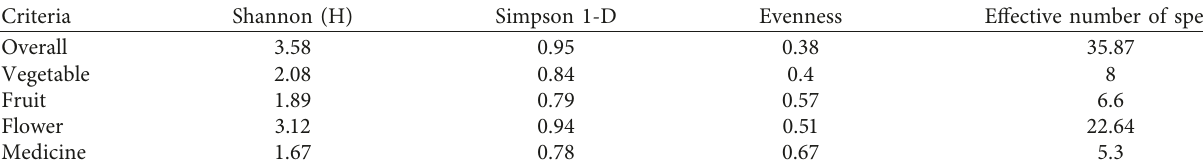
Table 8: Diversity indices of species reported in the study area.